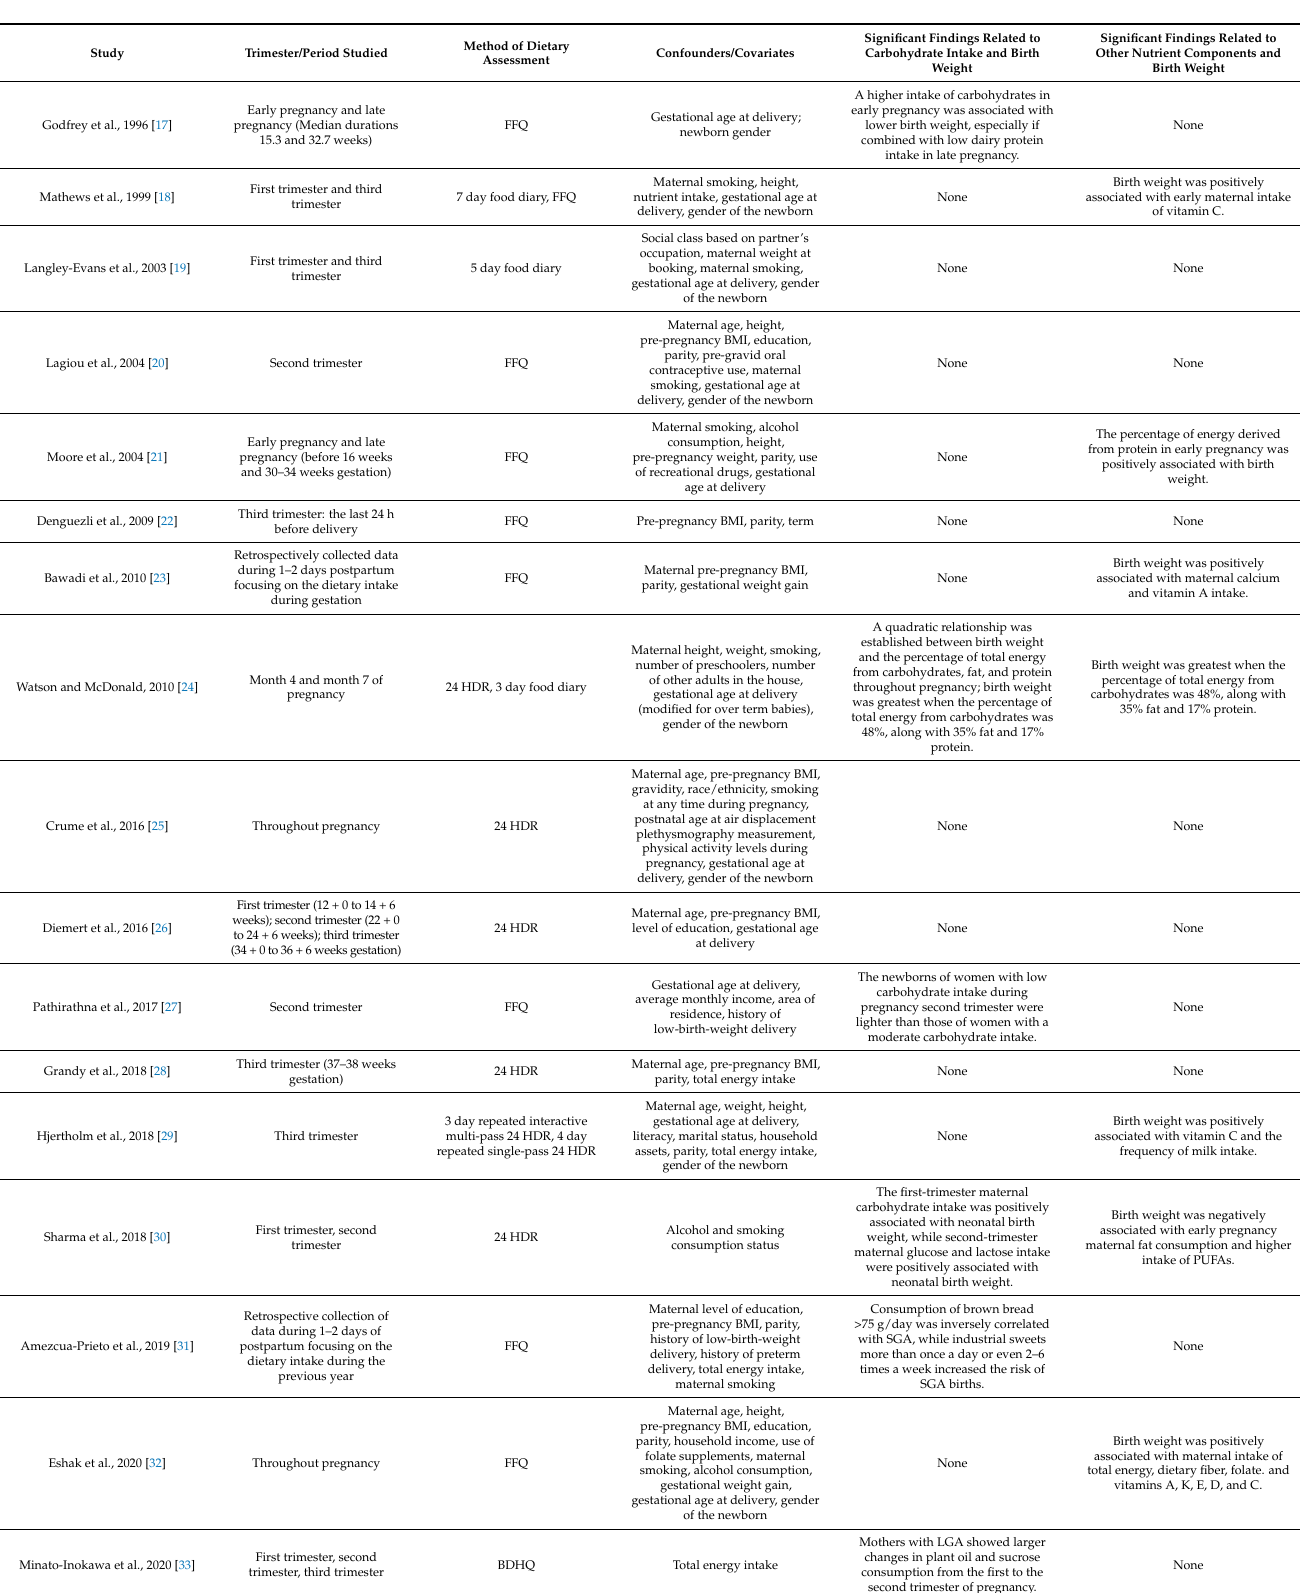
Table 2. Summary of findings from the included